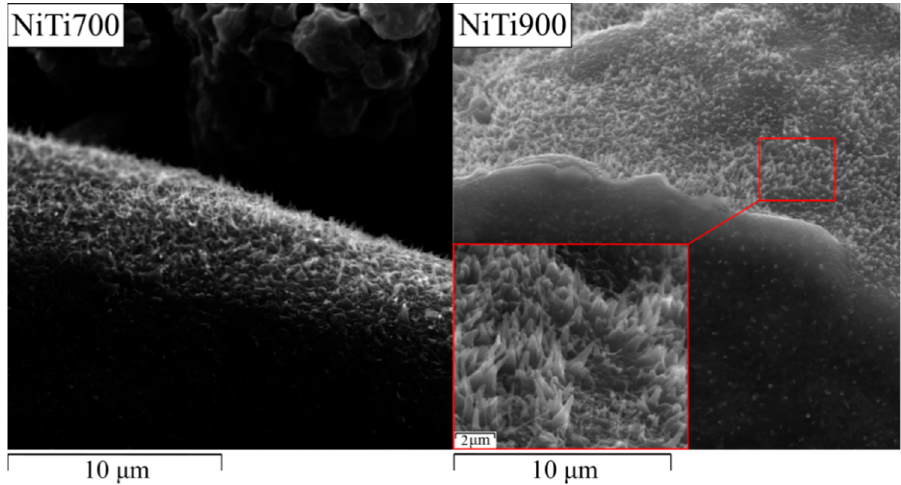
Figure 5. SEM crystals images grown up on the pore surfaces of the annealed samples.